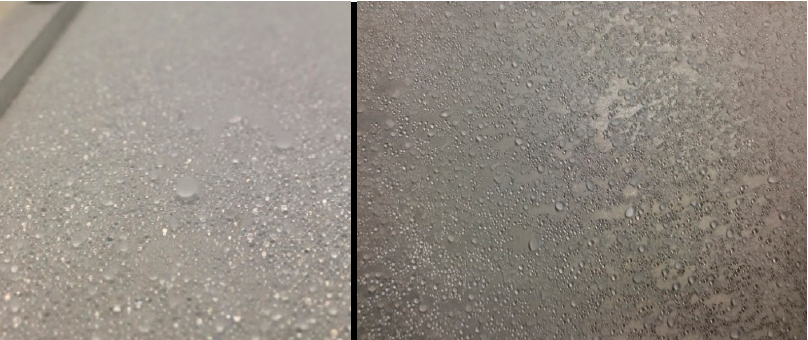
Figure 11. Precipitation on Superhydrophobic 2 during WSET with Fluid A.